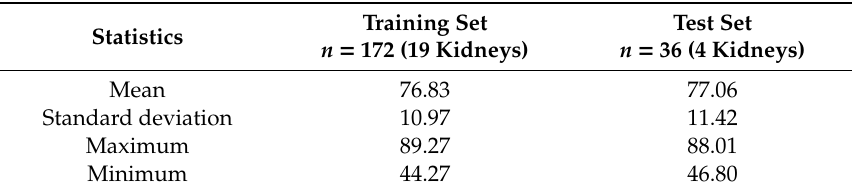
Table 2. Reference values of TWC in